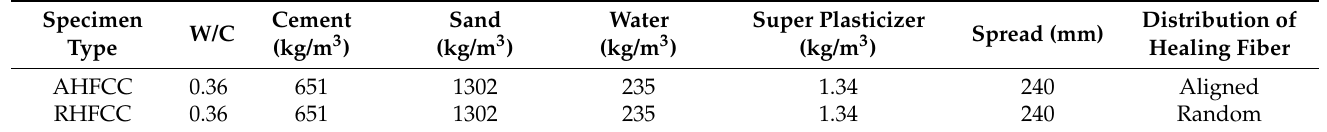
Table 1. Mixture design for the self-healing process.